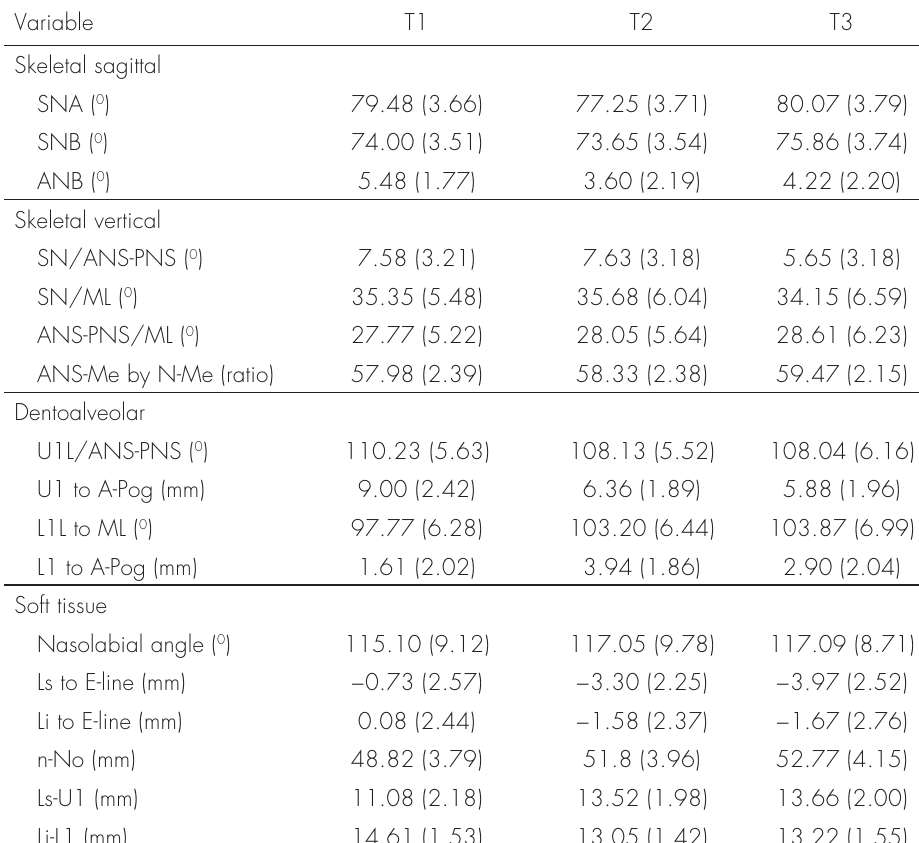
Table III. Descriptive statistics for cephalometric variables (mean and SD) at the start of treatment (T1), posttreatment (T2) and 2 years posttreatment